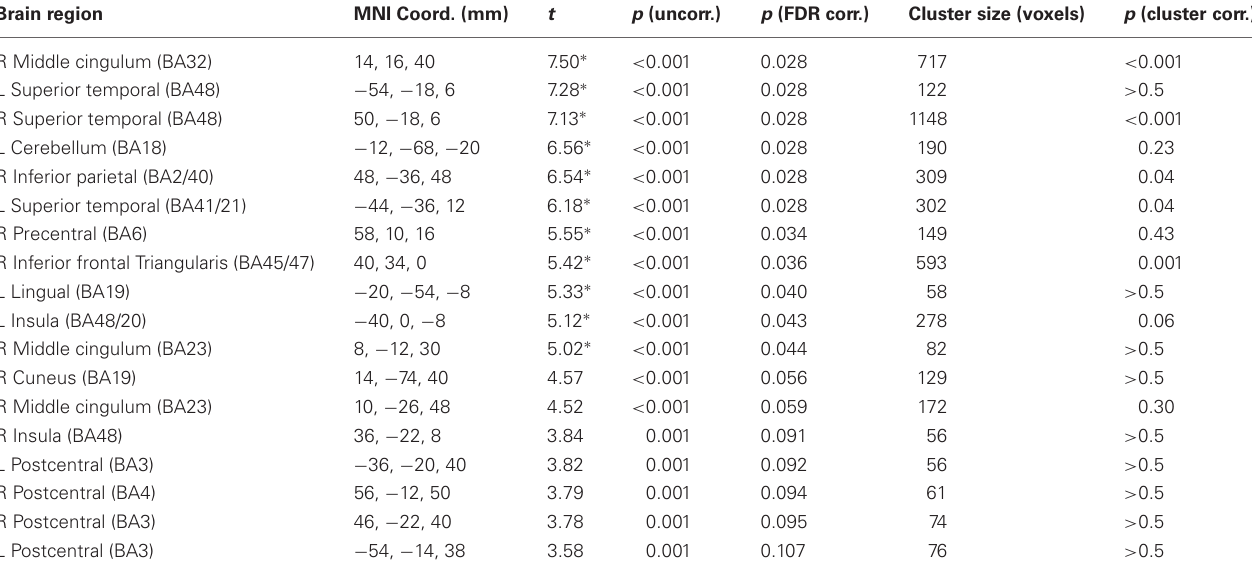
Table 4 | High vs. low abstraction, whole brain analysis. Brain region